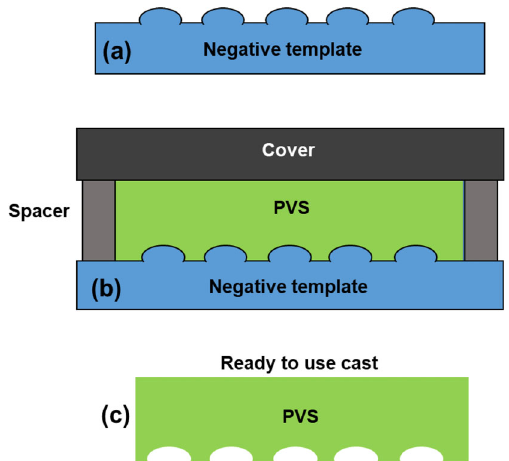
Fig. 1 Schematic illustration of casting process.